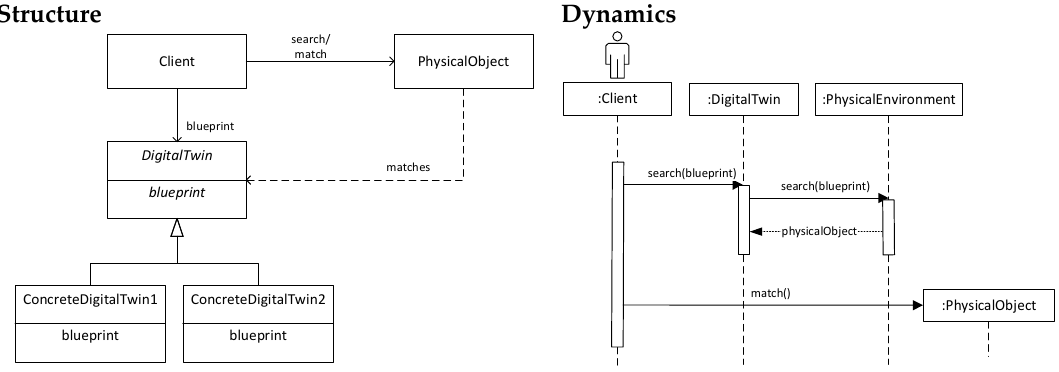
Figure 10. Digital Matching